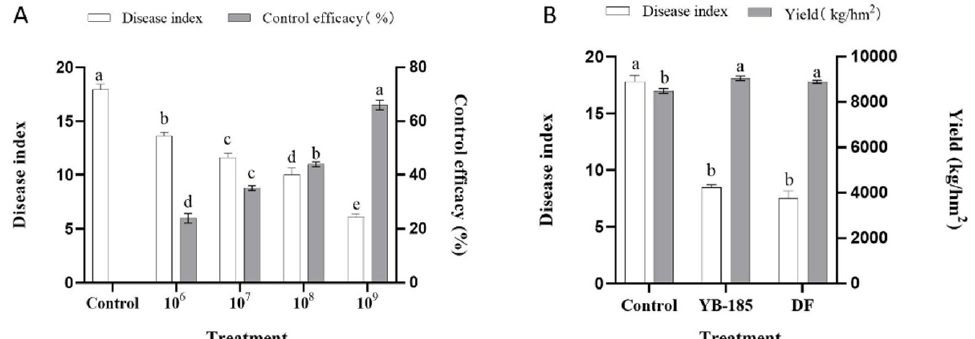
Figure 4. Effect of YB-185 on FCR in the greenhouse and field. ( A ) Disease index and control efficacy of FCR in the greenhouse with seed not treated (control) or treated with 10 6 , 10 7 , 10 8 , and 10 9 CFU/mL of YB-185; ( B ) disease index and grain yield in fields infested with F. pseudograminearum with seed not treated (control) or seed treated with 10 9 CFU/mL of YB-185 or 4.8% difenoconazole fludioxonil (DF). Different lowercase letters indicate a significant difference within groups ( p < 0.05) using one-way ANOVA.